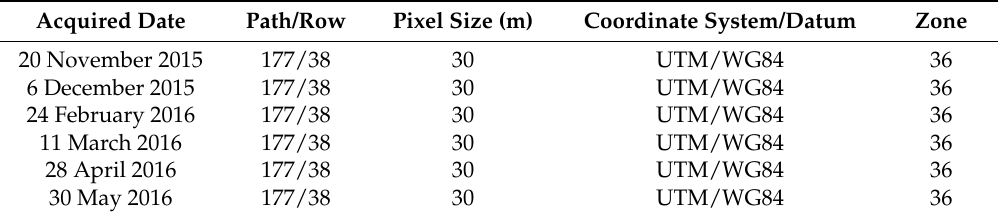
Table 2. Details of the Landsat8/ETM satellite images over the center of the Nile delta. Acquired Date